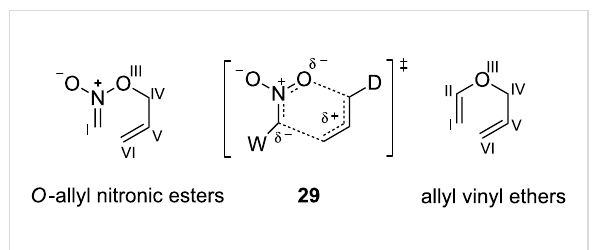
Scheme 6: General transition state for the [3,3]-sigmatropic rearrange- ment of O -allyl nitronic esters.